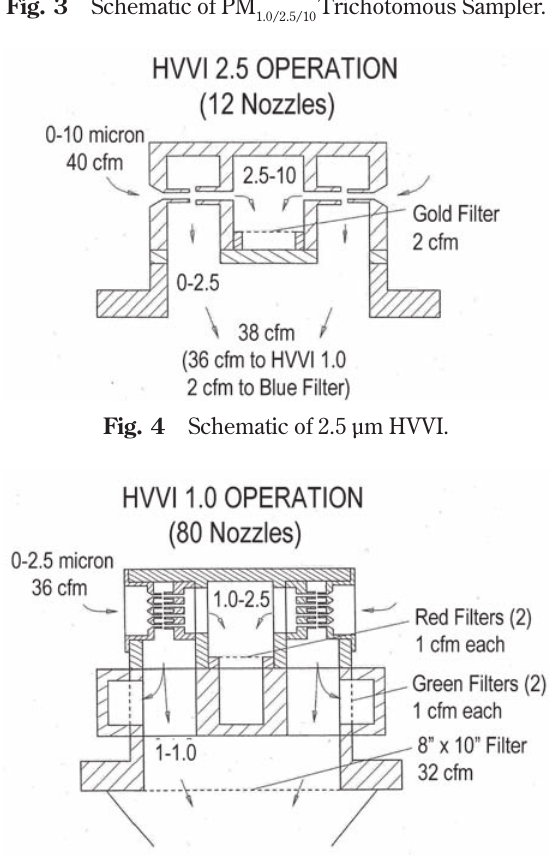
Fig. 5 Schematic of 1.0 µm